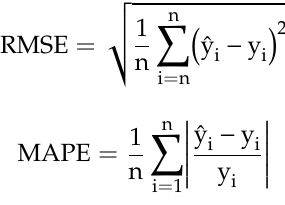
Table S1: The definitions of the involved VolSurf variables, Table S2: The k o ff values of 52 HSP inhibitors, Table S3: The k o ff values of 49 non-redundant HSP inhibitors, Table S4: The k o ff values of 46 A 1 AR ligands, Table S5: The k o ff values of 28 p38 MAPK